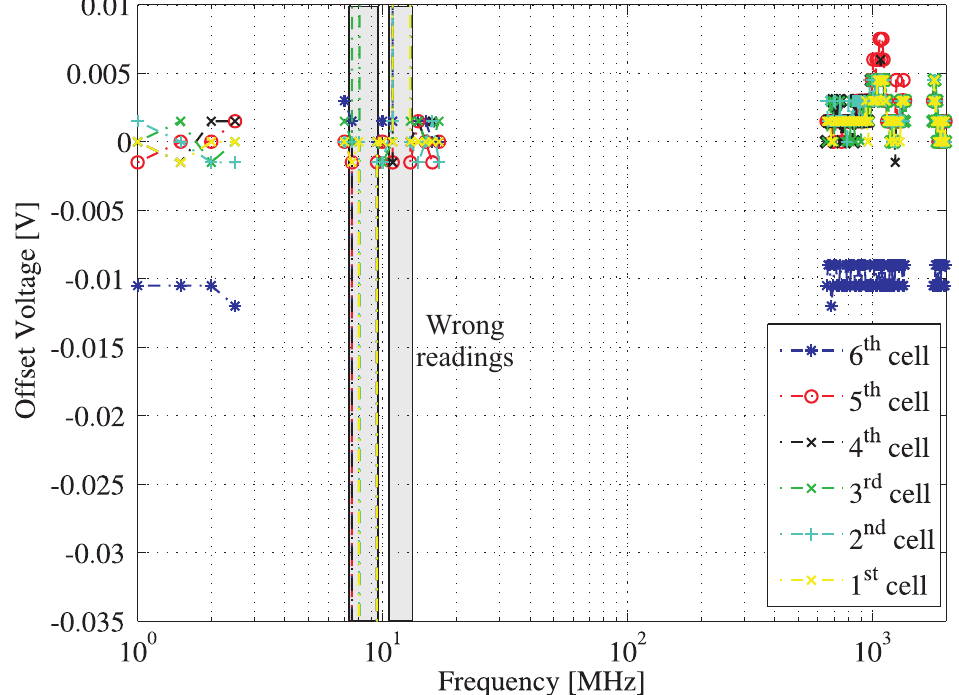
Figure 7. EMI-induced offset in the cell voltage readings obtained in accordance with DPI failures level of Figure 4 (DM injection performed on the 6th cell positive terminal, with RC